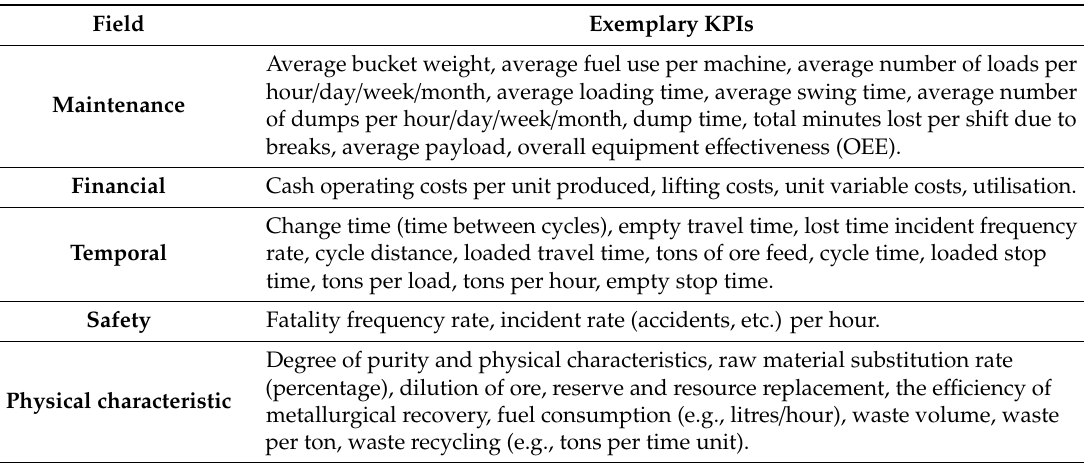
Table 3. Examples of KPIs in the selected